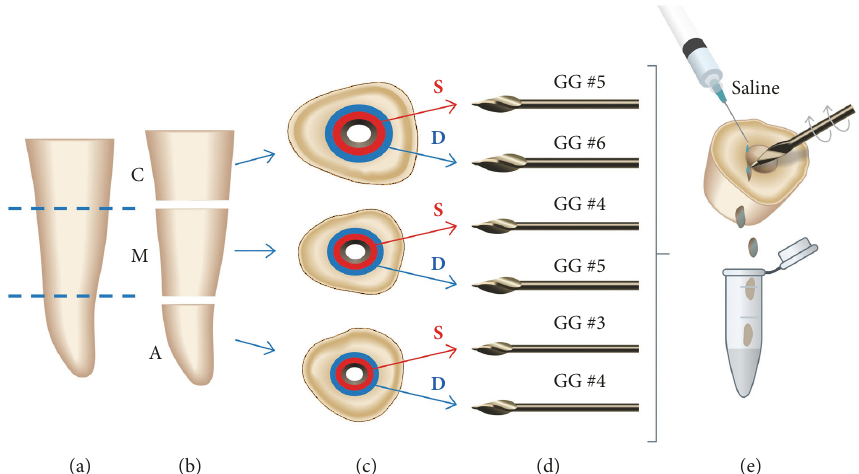
Figure 1: Schematic drawing of the dentin samples collection. (a) Root of human canine tooth. (b) Root sectioned into coronal (C), middle (M), and apical (A) segments. (c) Cross section of root segments showing the regions of the superficial (S) and deep (D) dentin. (d) Gates- Glidden (GG) drills #3 to #6 were used for obtaining dentin chips. (e) Dentin chips collected in microtubes under irrigation with sterilized